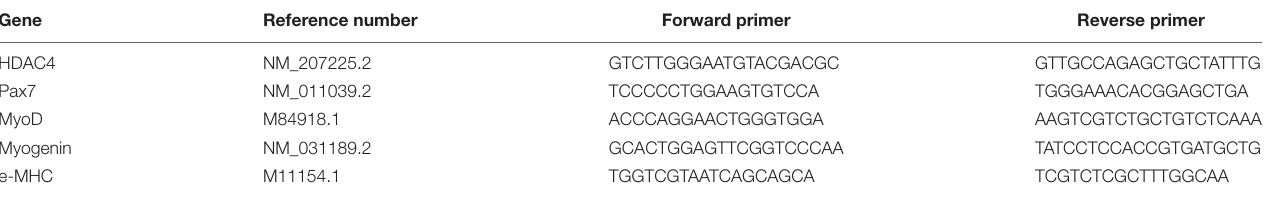
TABLE 1 | Primers used for real-time